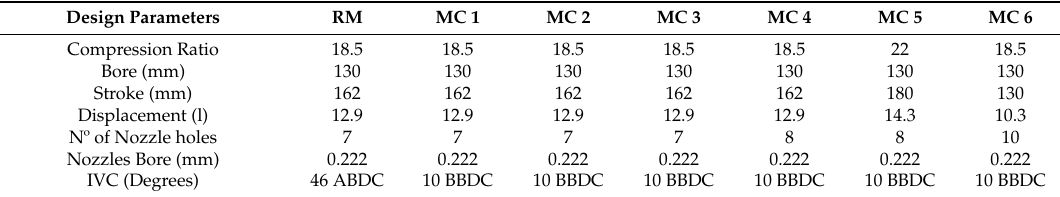
Table 3. Engine design parameters for all models.